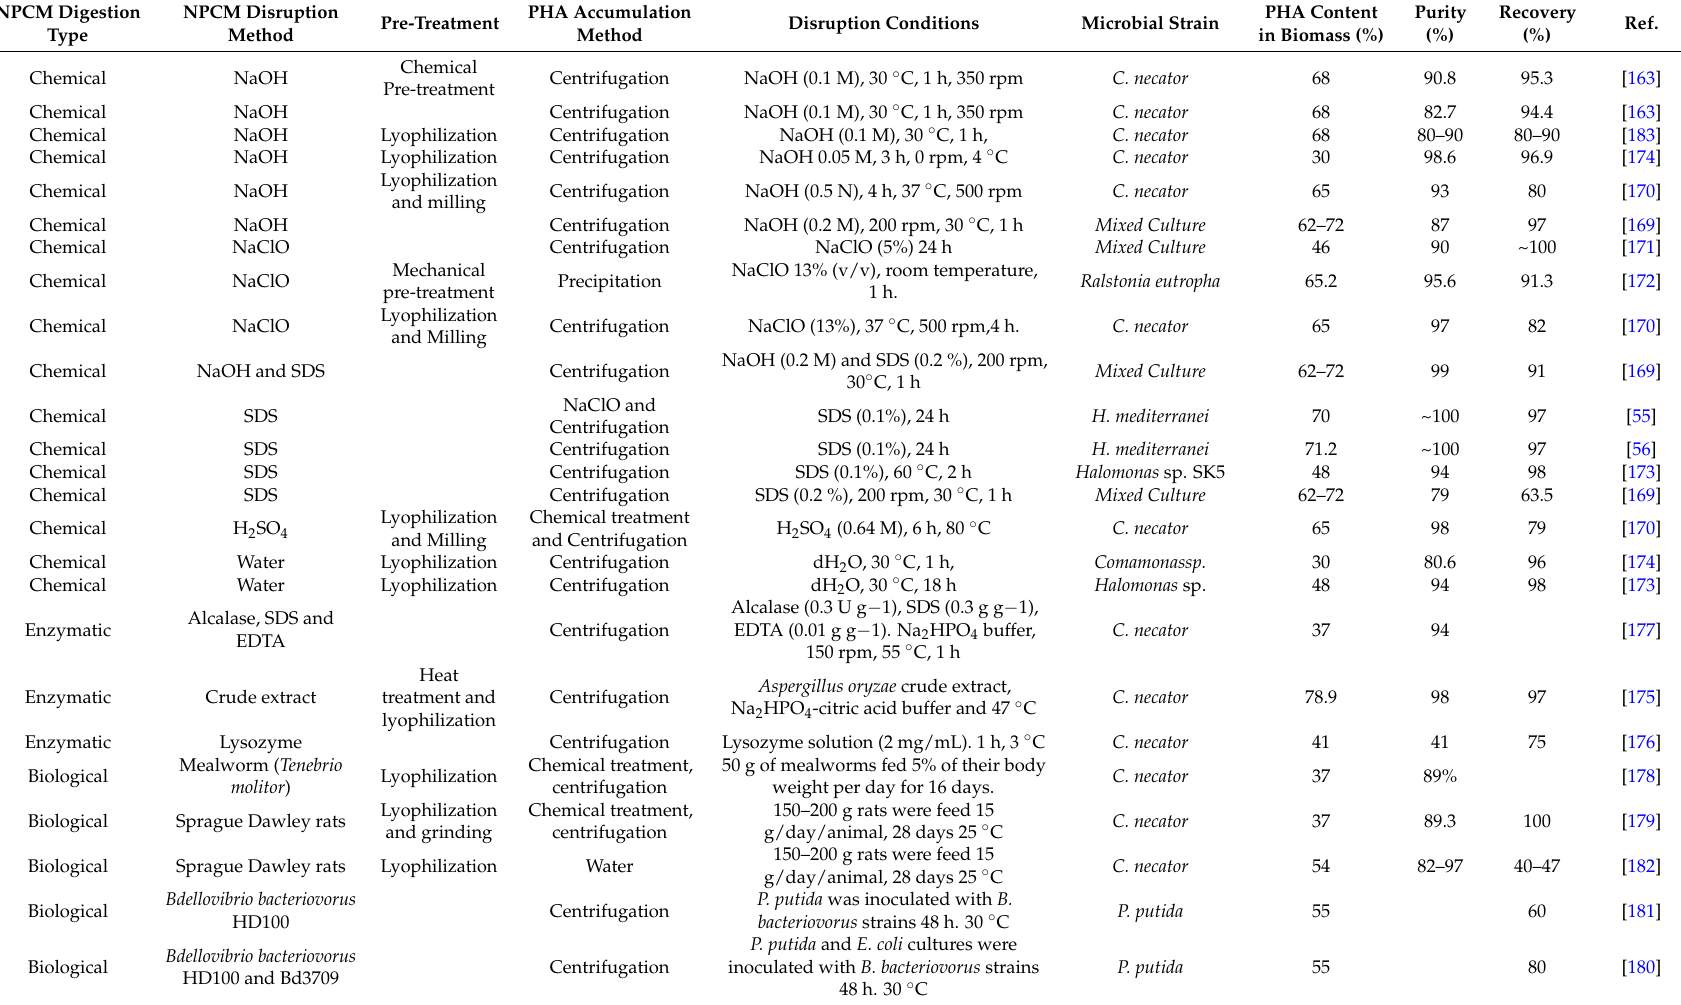
Table 6. NPCM chemical disruption